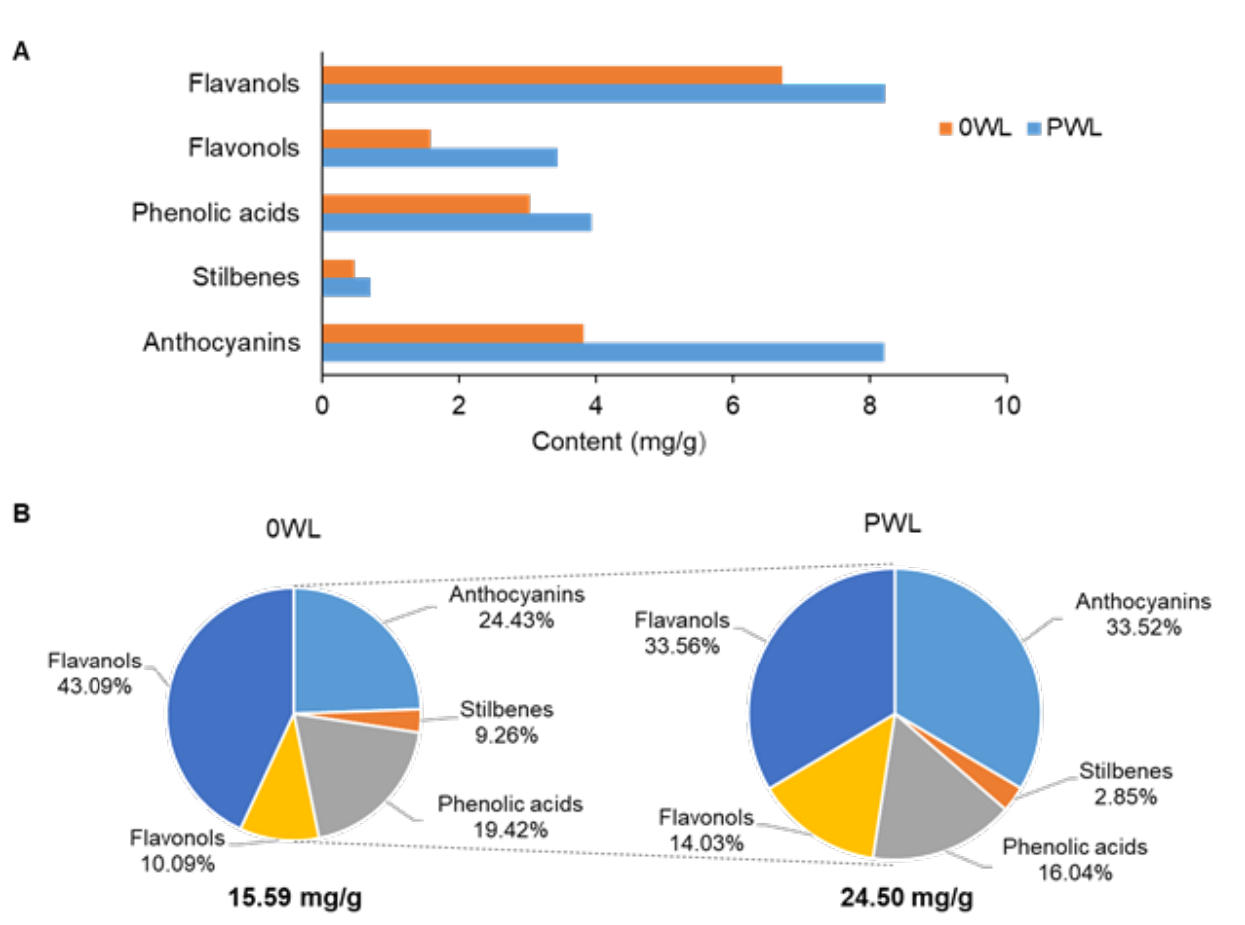
Figure 2. Flavanols, flavonols, phenolic acids, stilbenes, and anthocyanins content analyzed by UHPLC-(ESI)-Q-TOF-MS of control wine lees (0 WL) and phenolic-enriched wine lees (PWL) ( A ). Total phenolic compounds and percentages of the different families of phenolic compounds in 0 WL and PWL ( B ). Table 2. Non-anthocyanin characterization by UHPLC-(ESI-)-Q-TOF-MS in 0WL and PWL.